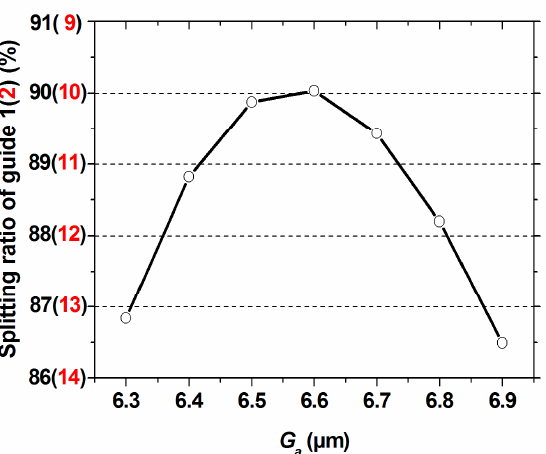
Figure 8. The curve of the splitting ratio against central gap G a .